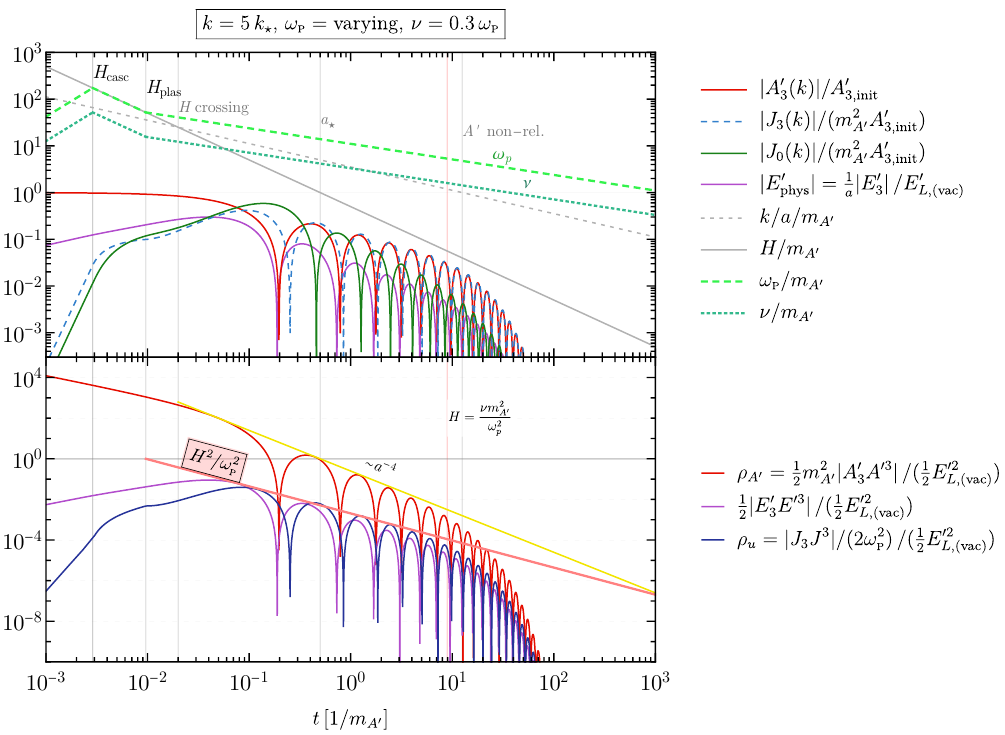
Figure 17. Evolution of the longitudinal field A 0 (denoted by A 0 ), the vector current J 3 and the 3 L current density J 0 , as governed by the Maxwell-Proca equation (C.6), the continuity equation (C.8) and the Euler equation (C.9). Upper panel : solution for A 3 , J 3 , J 0 and electric field E 3 with plasma mass ω p given in input as shown in the figure, and collision rate ν set to 0 . 3 ω p . The results are normalised to either the initial value A 0 or the electric field at horizon entry in vacuum 3,init E 0 ≡ m A 0 H I / (2 π ) . We choose the mode k = 5 k ? , but very similar results hold for any k L, vac entering the horizon between H plas and the decay time of the modes, shown with a vertical red line. Lower panel: corresponding energy densities, as defined in table 1. The most relevant point for our discussion is that the kinetic energy density of the plasma is capped by H 2 E 0 2 , as shown by the L, vac ω 2 p pink